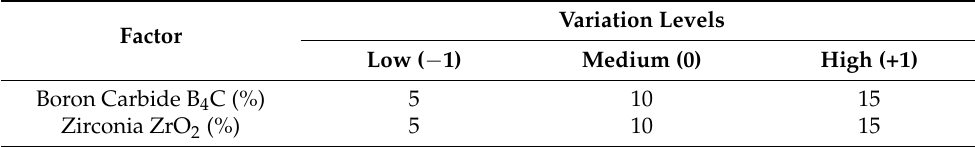
Table 2. Experimental design